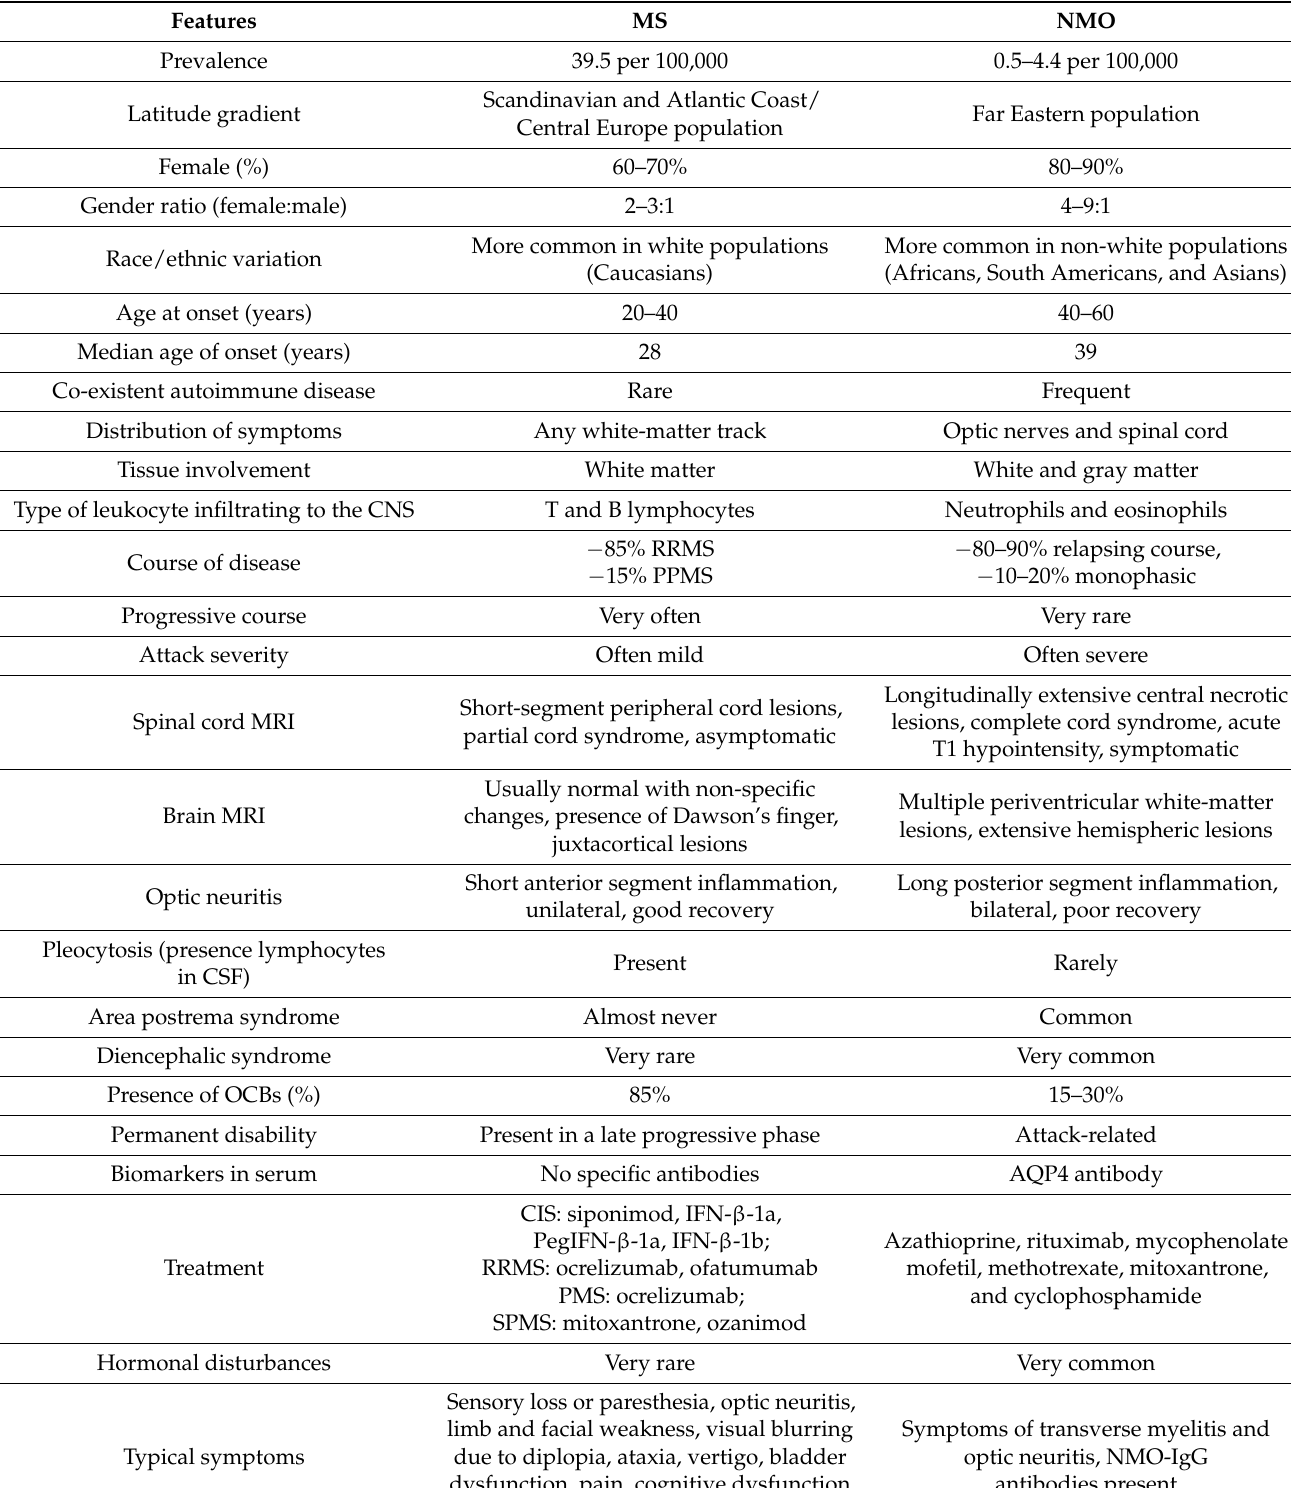
Table 1. Features differentiating MS from NMO